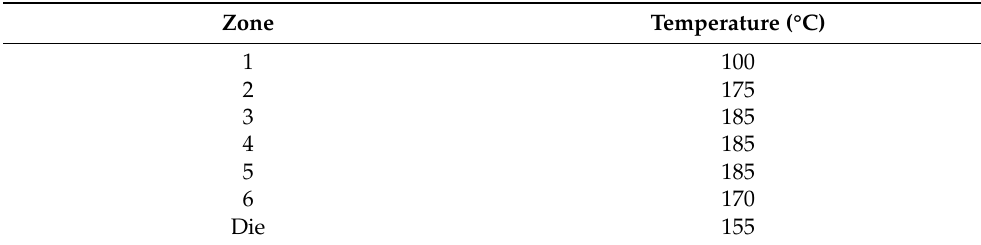
Table 2. The profile of temperature zones of the RES-2P/12A Explorer twin-screw extruder.